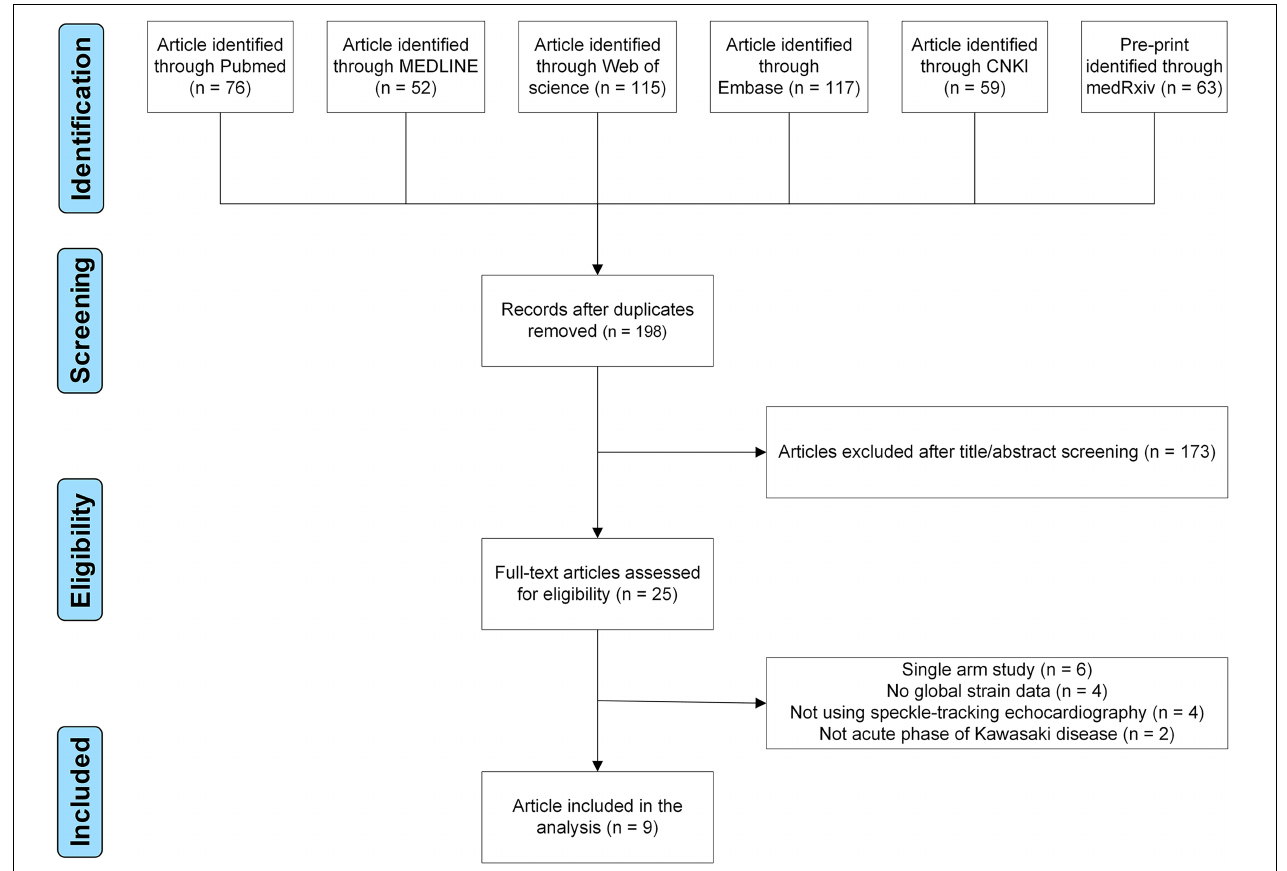
FIGURE 1 | Flow chart of study